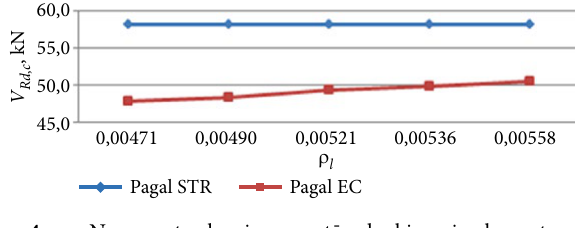
4 pav. Nearmuotų skersine armatūra lenkiamųjų elementų įstrižojo pjūvio stiprumo priklausomybė nuo išilginio armavimo koeficiento Fig. 4. The relationship between shear section strength of bending elements without shear reinforcement and longitudinal reinforcement ratio